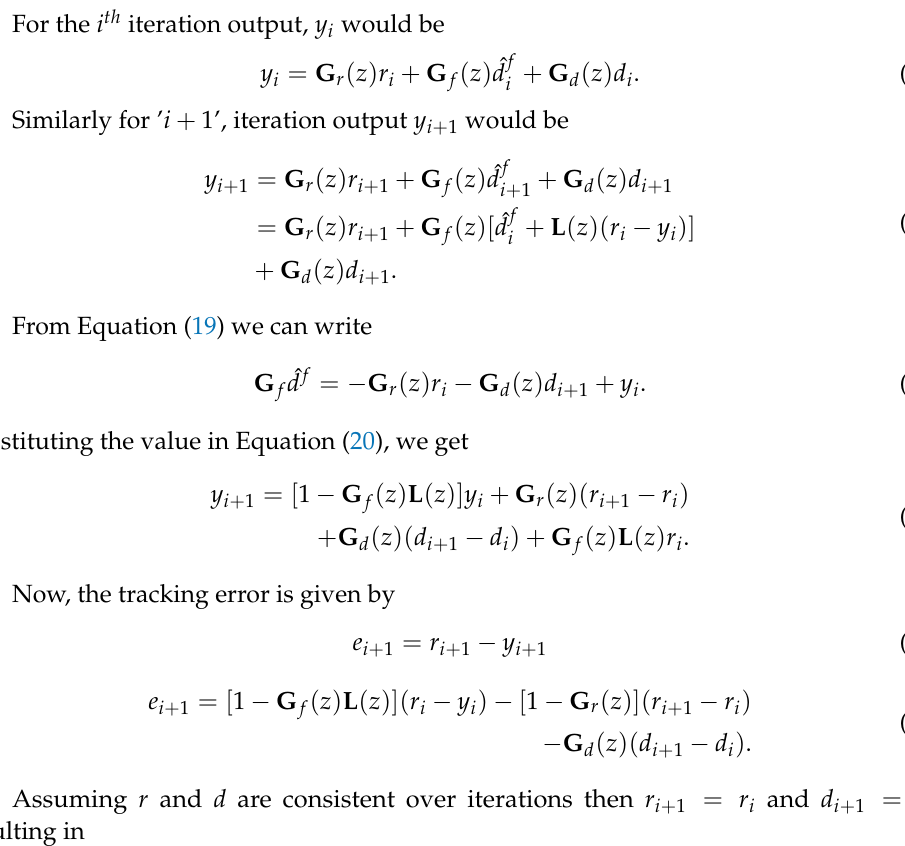
Figure 5. Learning-based disturbance observer scheme with PI